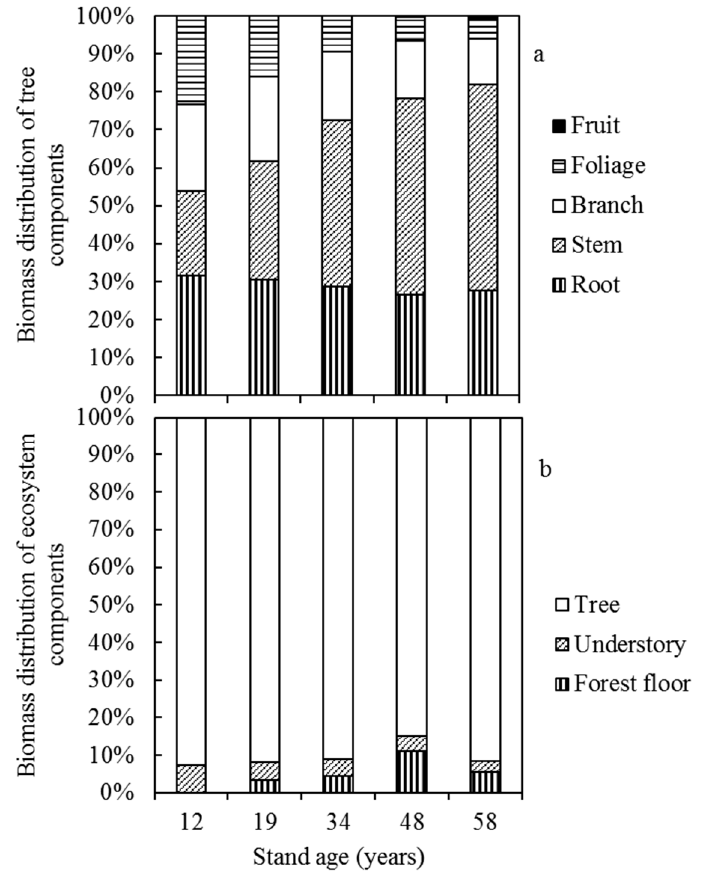
Figure 2. Biomass percentage distribution of tree individual components ( a ) and ecosystem components ( b ) in the 12-, 19-, 34-, 48-, and 58-year-old Mongolian pine ( Pinus sylvestris L. var. mongolica Litv.) plantations.